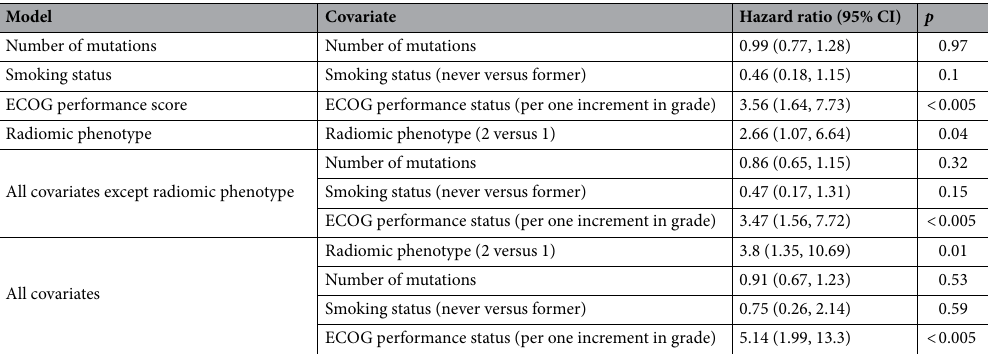
Table 2. Progression-free survival Cox regression hazard